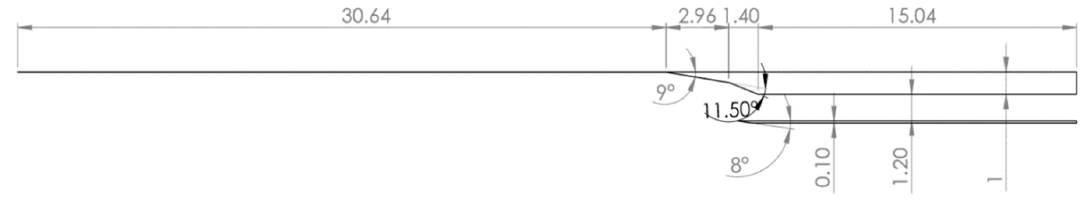
Figure 8. Two ramp inlet schematic (dimensions in metres).